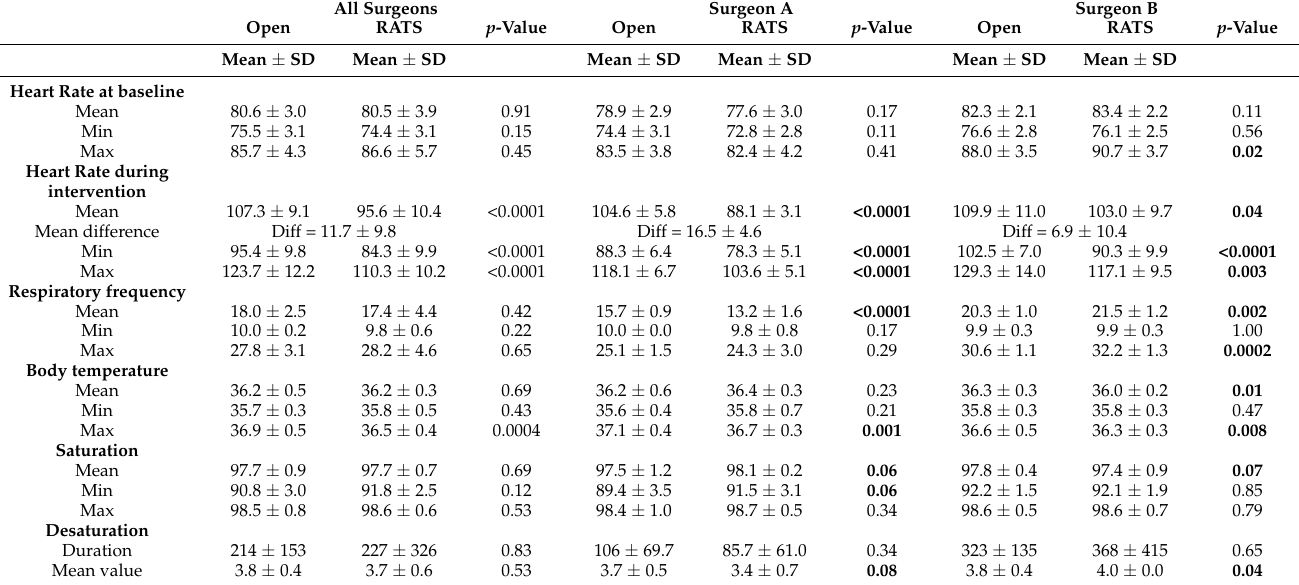
Table 2. Intraoperative respiratory and cardiovascular outcomes of the surgeons. All Surgeons Surgeon A Surgeon B Open RATS p -Value Open RATS p -Value Open RATS p -Value